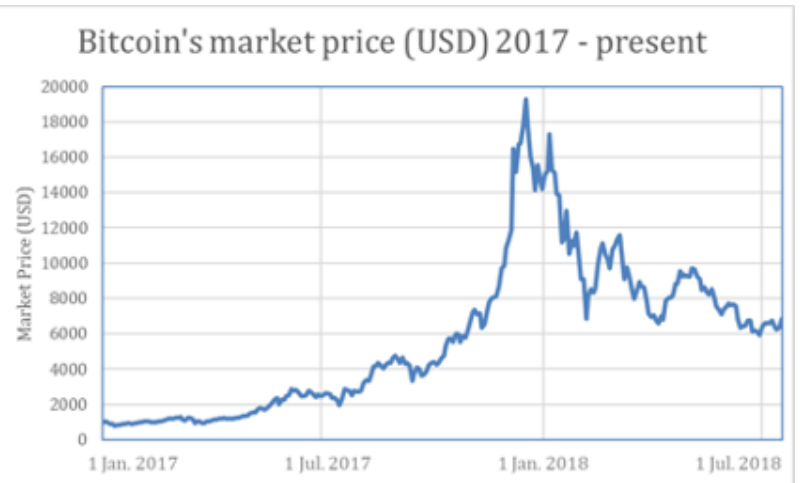
Figure 3: Bitcoin’s market price 2017–present (source: Own elaboration based on data collected on